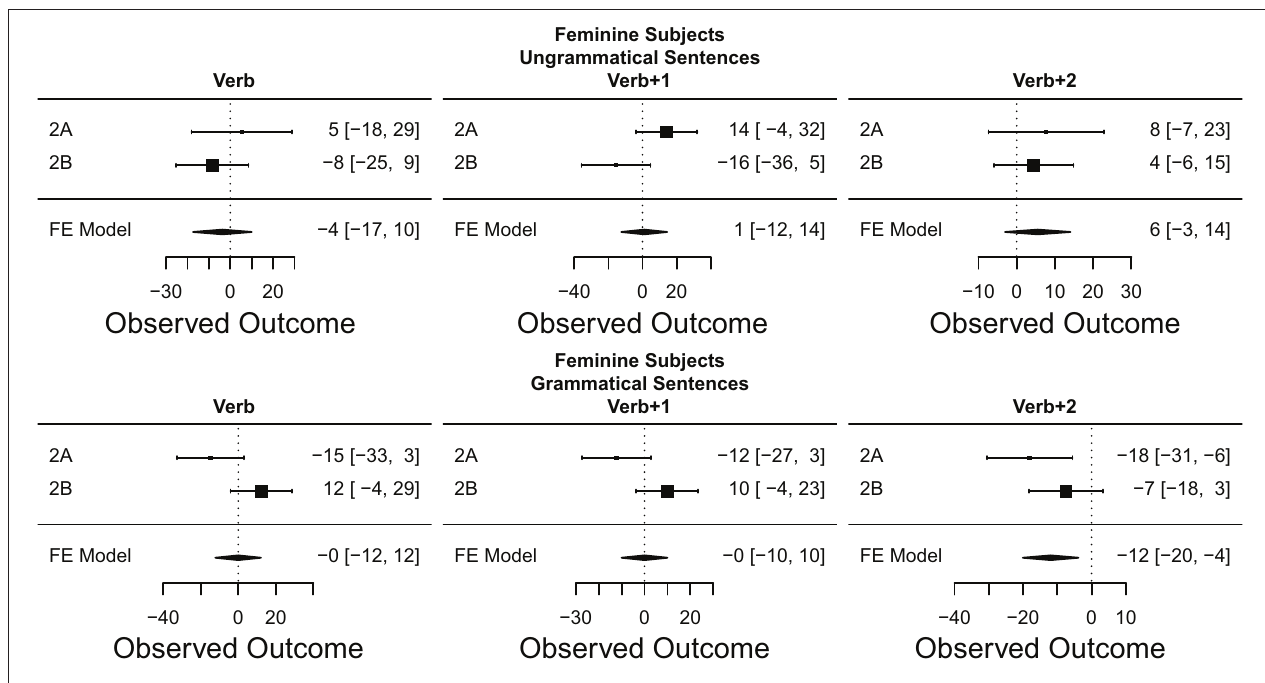
Figure 7 | Gender effect in ungrammatical and grammatical sentences: forest plots of meta-analysis for feminine subjects. The size of the square representing each experiment is proportional to its weight in the meta-analysis. The estimated effect size of the meta-analysis is represented by the black diamond at the bottom of each graph. The width of the diamond represents the estimated 95% CI of the meta-analysis effect size. Experiments are plotted in chronological order from top to bottom.